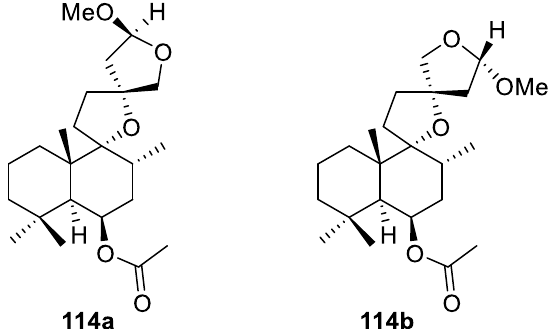
Figure 51. Spirocyclic labdane – type diterpenoids isolated from the fruit of Vitex agnus-castus .